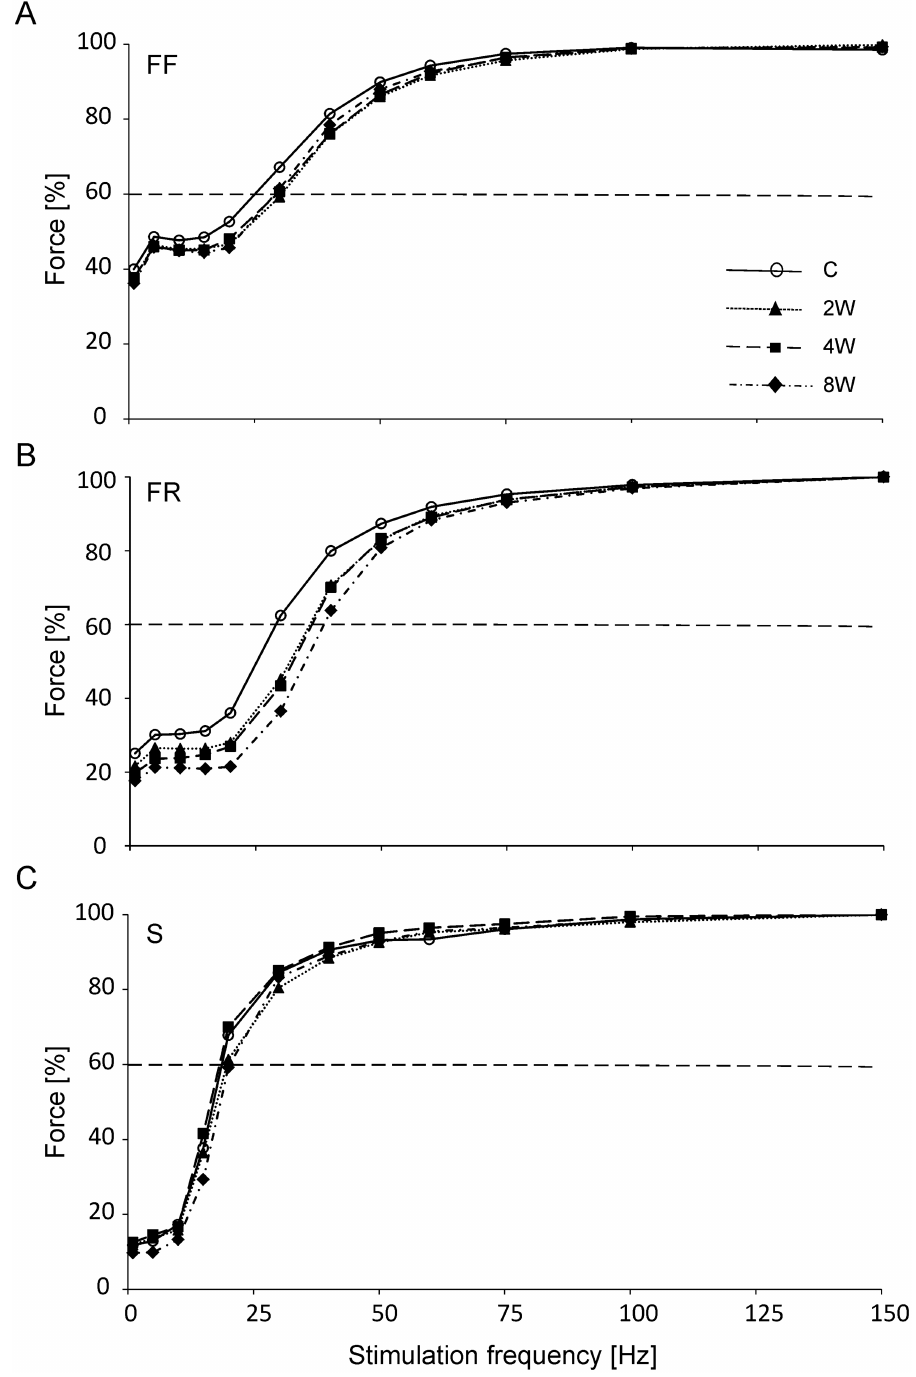
Fig 4. Force-frequency relationships of the three motor unit types in control and trained animals. Fast fatigable (FF) motor units (MUs) are presented in panel A, fast fatigue resistant (FR) MUs in panel B, and slow (S) MUs in panel C. The control (C) group is represented by open circles, the group trained for 2 weeks (2W) is represented by filled triangles, the group trained for 4 weeks (4W) is represented by filled squares, and the group trained for 8 weeks (8W) is represented by filled diamonds. The dashed horizontal lines in panels A–C indicate the level of 60% of the maximum force (normalized to the maximum tetanus force obtained at 150 Hz) (S6 File).